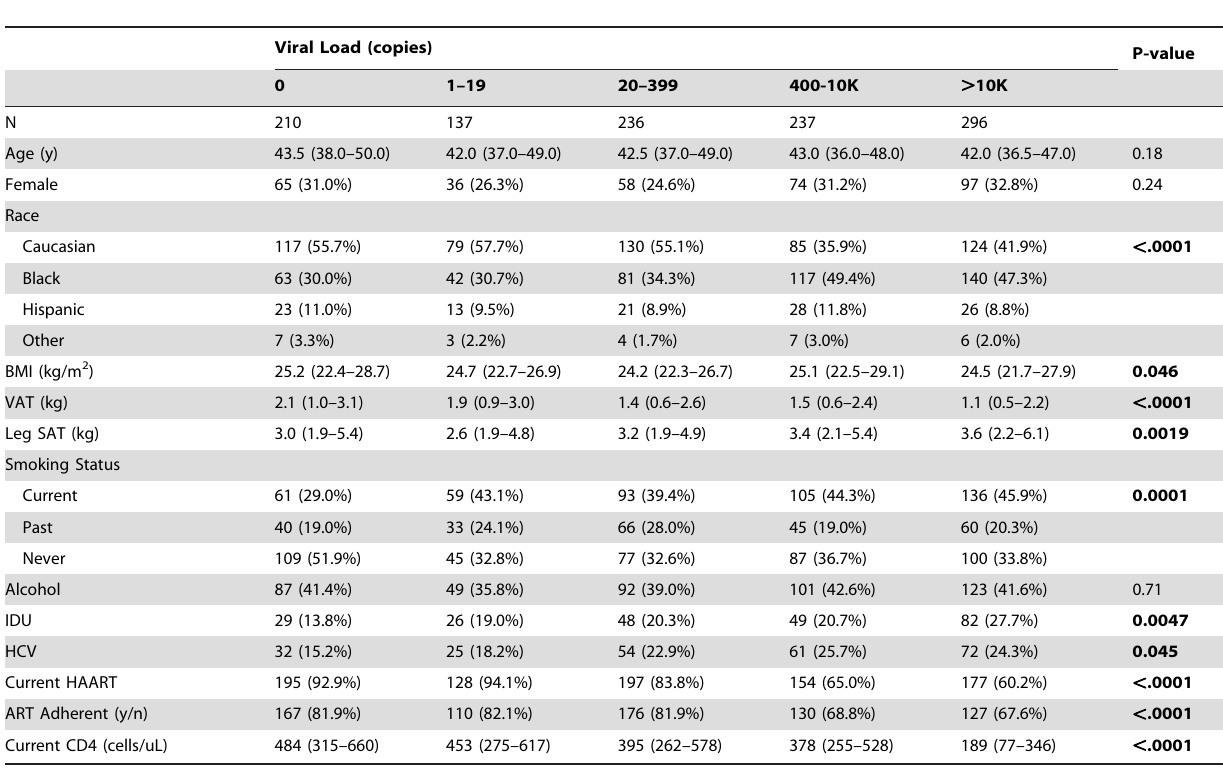
Table 1. Baseline demographic and clinical characteristics of HIV-infected participants by HIV viral load